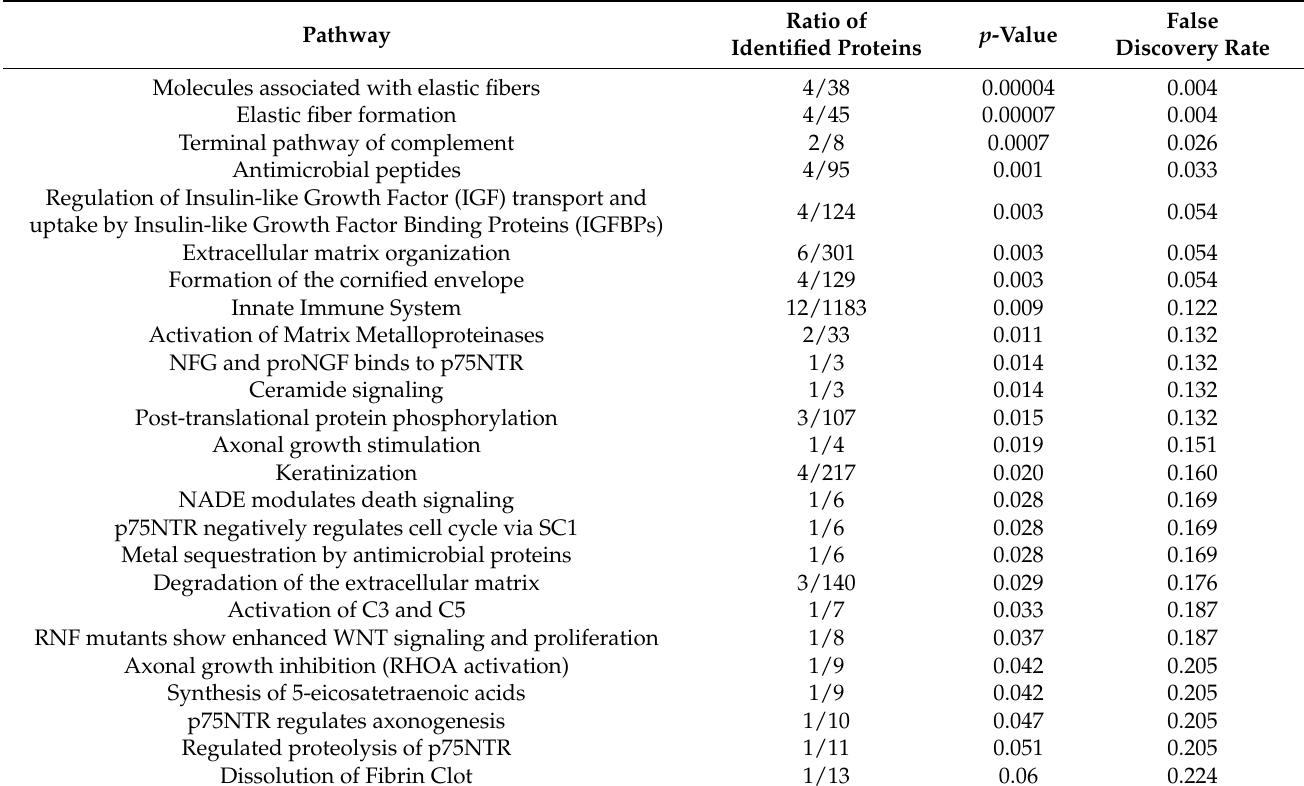
Table 5. Pathway analysis of most relevant proteins of the control group (ranked according to the p -value of the enrichment analysis of the Reactome Pathway Analysis of the OAB group; modified after Fabregat et al.